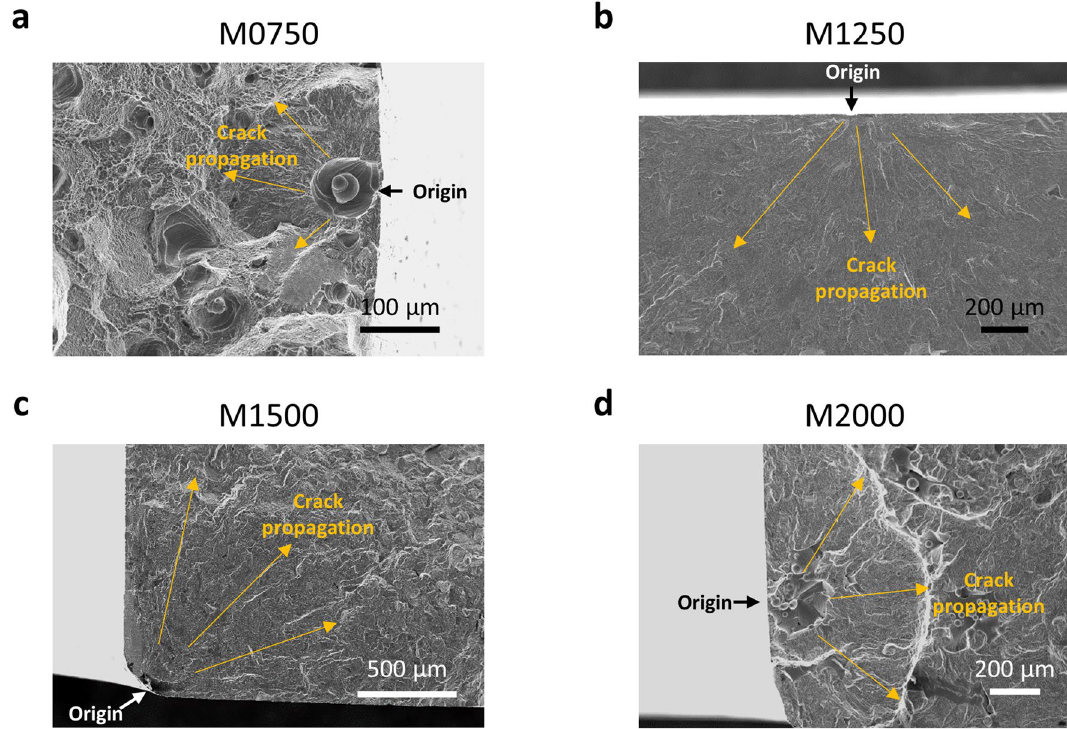
Figure 13. Fractography SEM images for various crack initiations. (a) For a M0750 sample (machined sample printed at a speed of 750 mm/s), crack initiates from an open pore located on the surface. (b) For a M1250 sample, crack initiates from the surface. (c) For a M1500 sample, crack initiates from the corner of the sample. (d) For a M2000 sample, crack initiates from a surface pore, which shows characteristics of